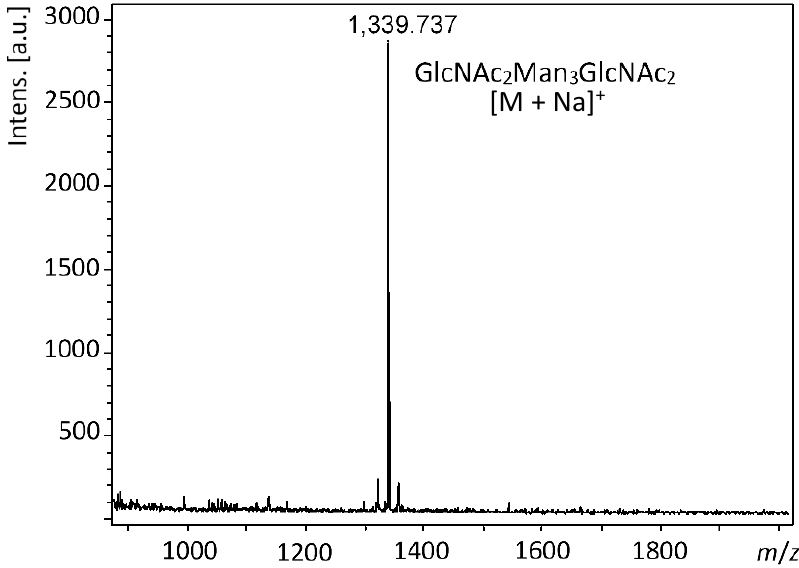
Figure 5. MALDI-TOF MS analysis result of the N-glycan released from the RNase B product of OP5E reactions; m / z calculated for the sodium adduct of the product GlcNAc 2 Man 3 GlcNAc 2 [M + Na] + was 1339.476, found 1339.737.